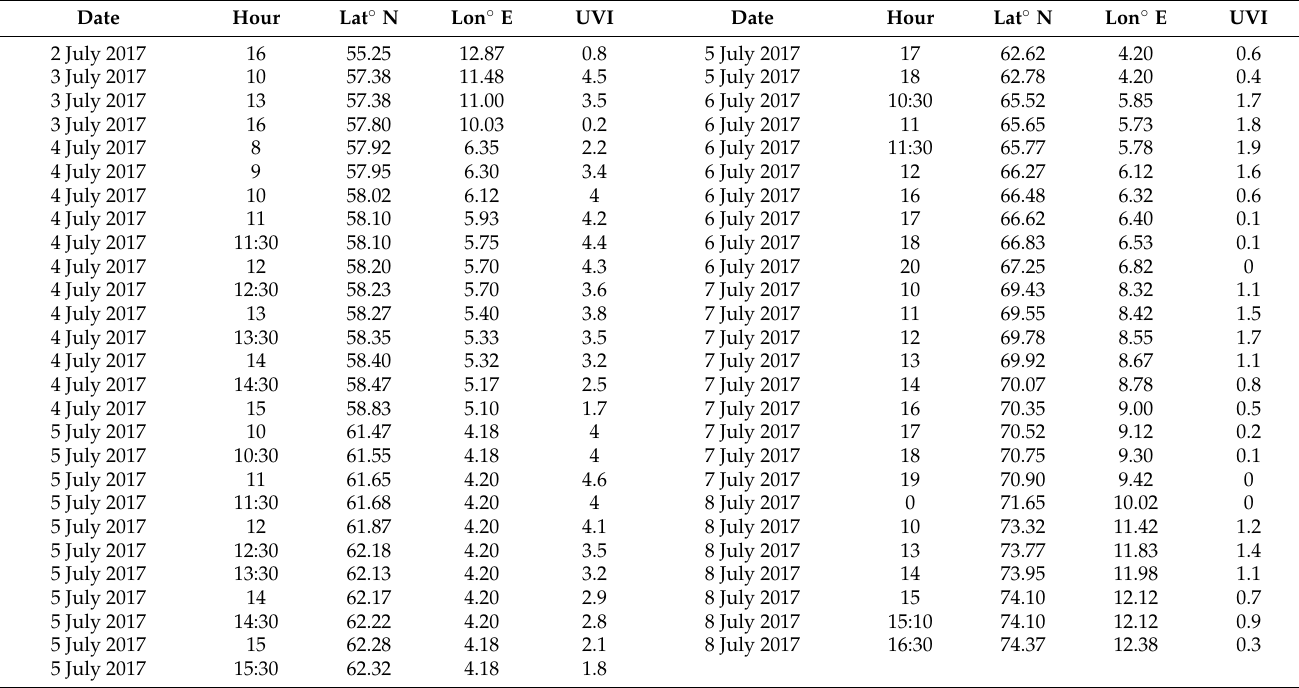
Table A1. Time, longitude, and latitude at the measuring site together with the observed UV index during the MS Horyzont II cruise from Gdynia-to Spitsbergen in the period 2–8 July 2017 (days 183–189).